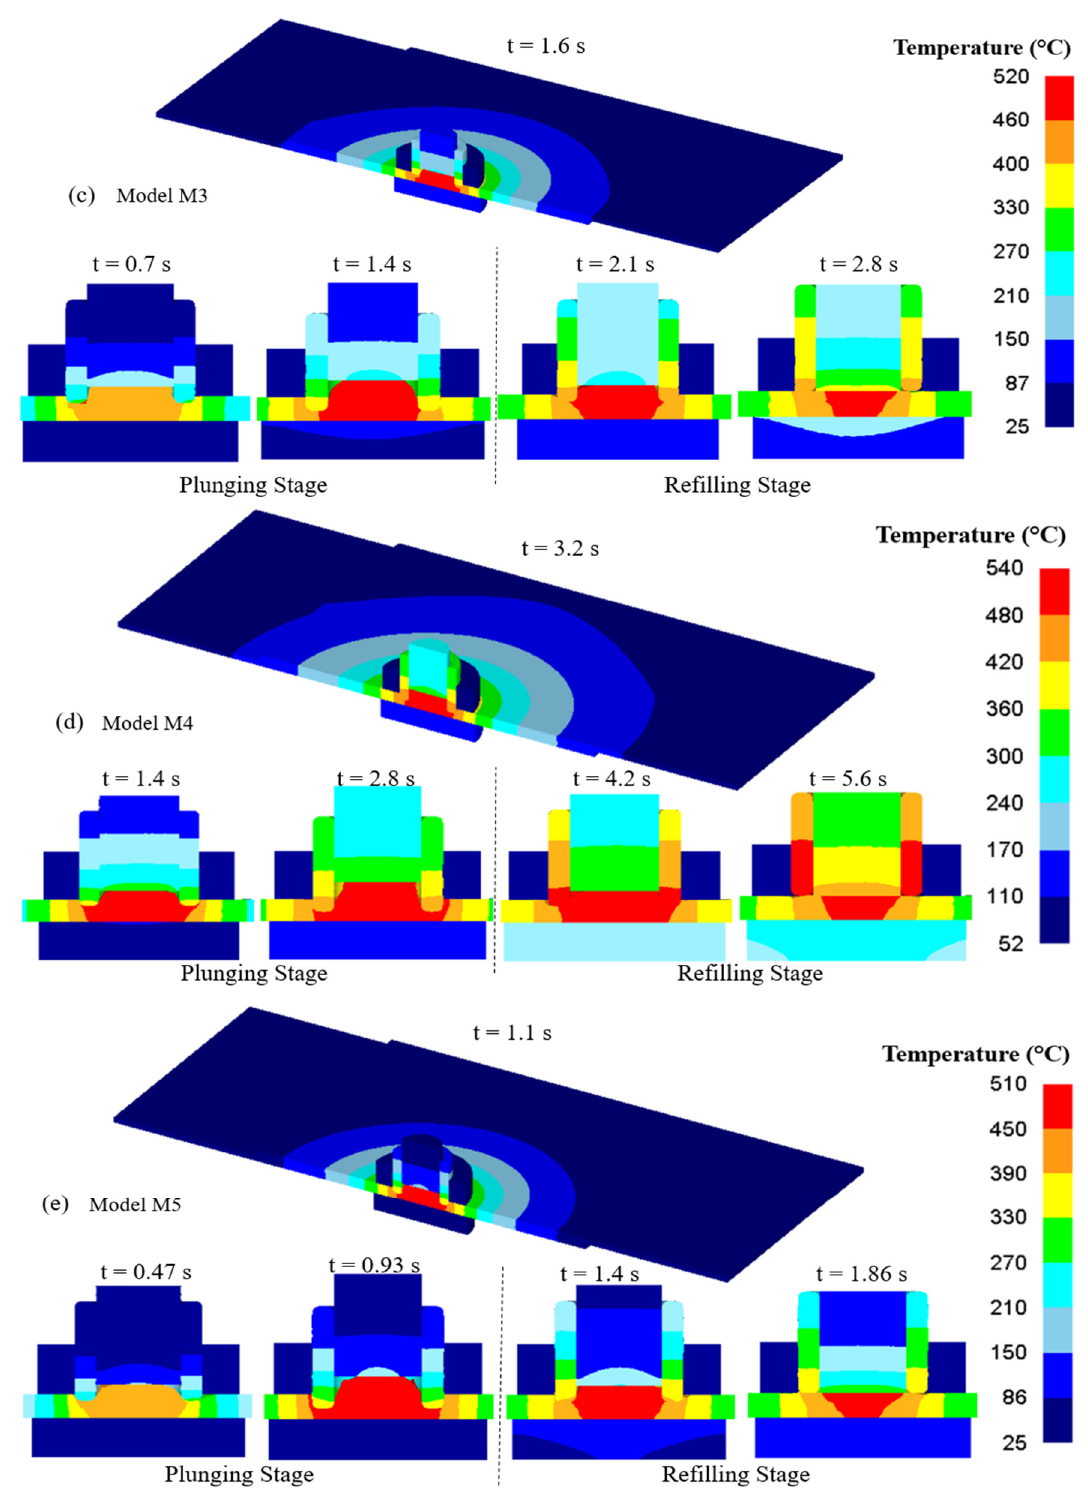
Figure 4. Temperature distribution in the process of refill FSSW from the simulations ( a ) Model M1; ( b ) Model M2; ( c ) Model M3; ( d ) Model M4; ( e ) Model M5. ( b ) Model M2; ( c ) Model M3; ( d ) Model M4; ( e ) Model